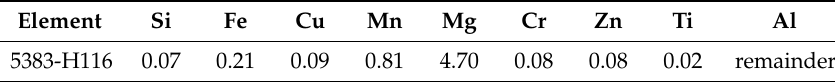
Table 1. The components of 5383-H116 Al-Mg alloy (wt.